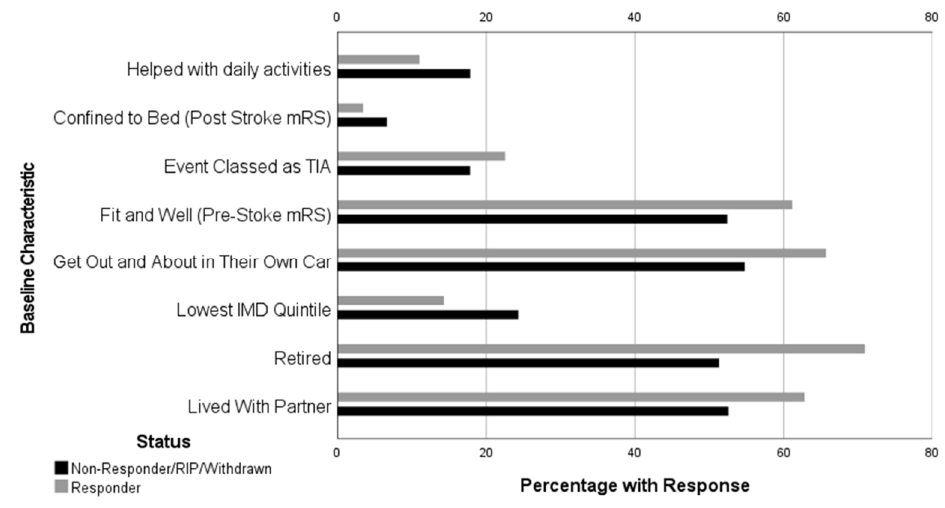
Figure 2. Differences in responders and non-responders baseline characteristics.